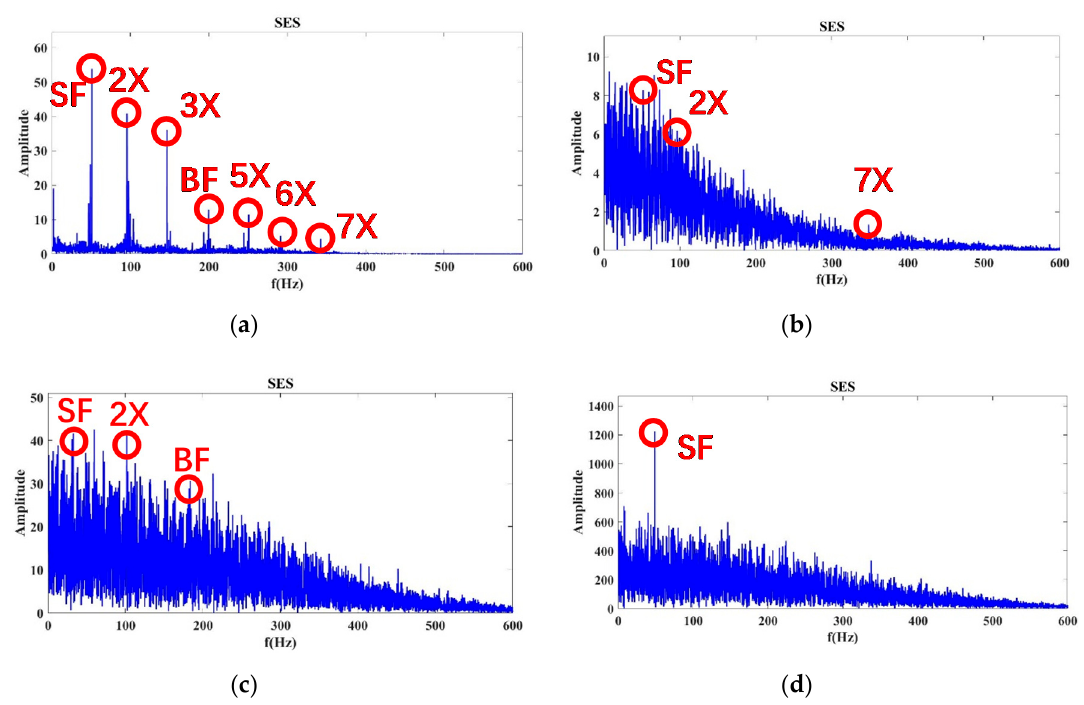
Figure 10. Results of the SES spectrum of the Autogram at a 110% flow rate at Sensor 15: ( a ) Status 1: No cavitation; ( b ) Status 8: Incipient cavitation; ( c ) Status 9: Severe cavitation; ( d ) Status 10: Very